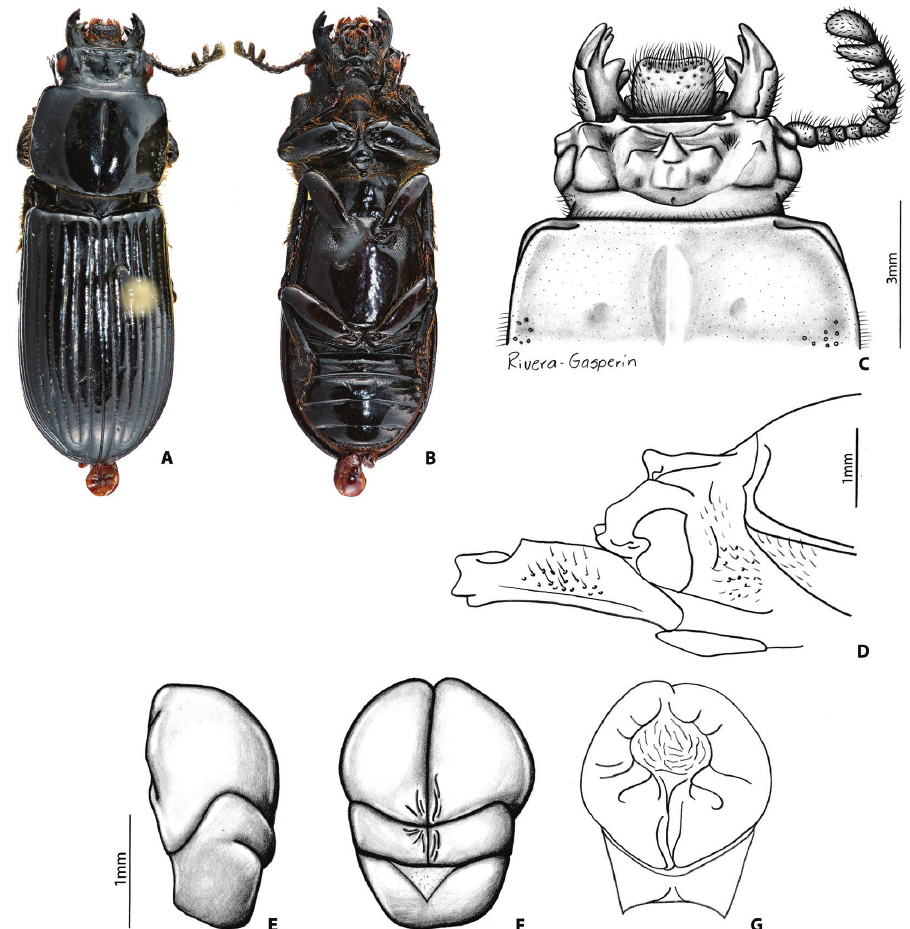
Figure 9. Yumtaax jimenezi Beza-Beza, Reyes-Castillo & Jameson, sp. n. , holotype: A dorsal habitus B ventral habitus C dorsal view of pronotum and head D lateral view of pronotum and head E lateral view of aedeagus F ventral view of aedeagus G dorsal view of